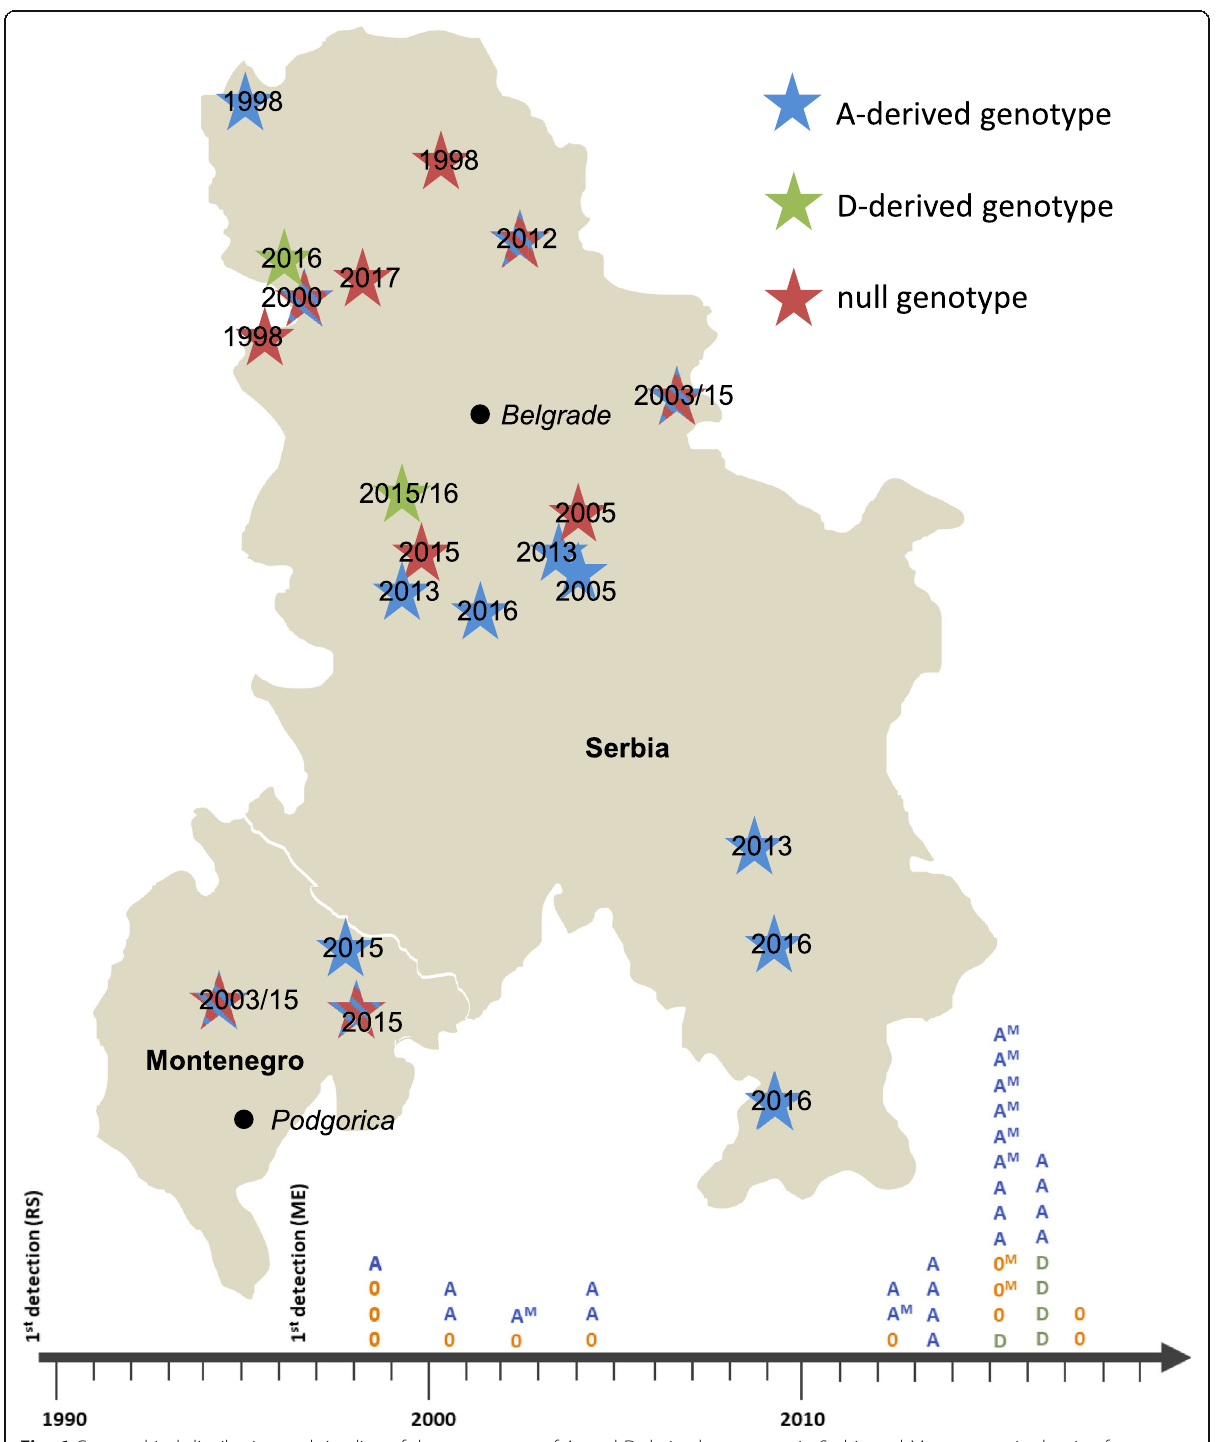
Fig. 6 Geographical distribution and timeline of the appearance of A- and D-derived genotypes in Serbia and Montenegro in the timeframe 1998 – 2017. Striped stars indicate the presence of two genotypes in one geographical location. The null PCR genotype (labelled as 0 in the timeline) is indicated in red. The M superscript indicates the isolates from